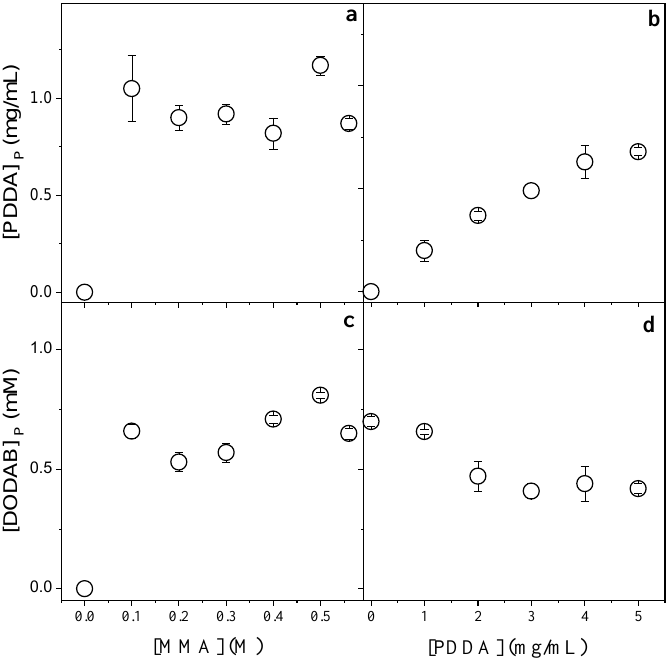
Figure 2. Effect of MMA and PDDA concentrations used in the NPs synthesis on [PDDA] P ( a , b ) and [DODAB] P in the PMMA/DODAB/PDDA NPs ( c , d ). All dispersions were synthesized by the emulsion polymerization method using 1.5 mM of DODAB and 0.0036 g AIBN. The effect of [MMA] on incorporation of the cationic components was performed at 5 mg/mL PDDA, whereas the effect of [PDDA] on incorporation of the cationic components was performed at 0.2 M MMA. These determinations were carried out after dialysis.